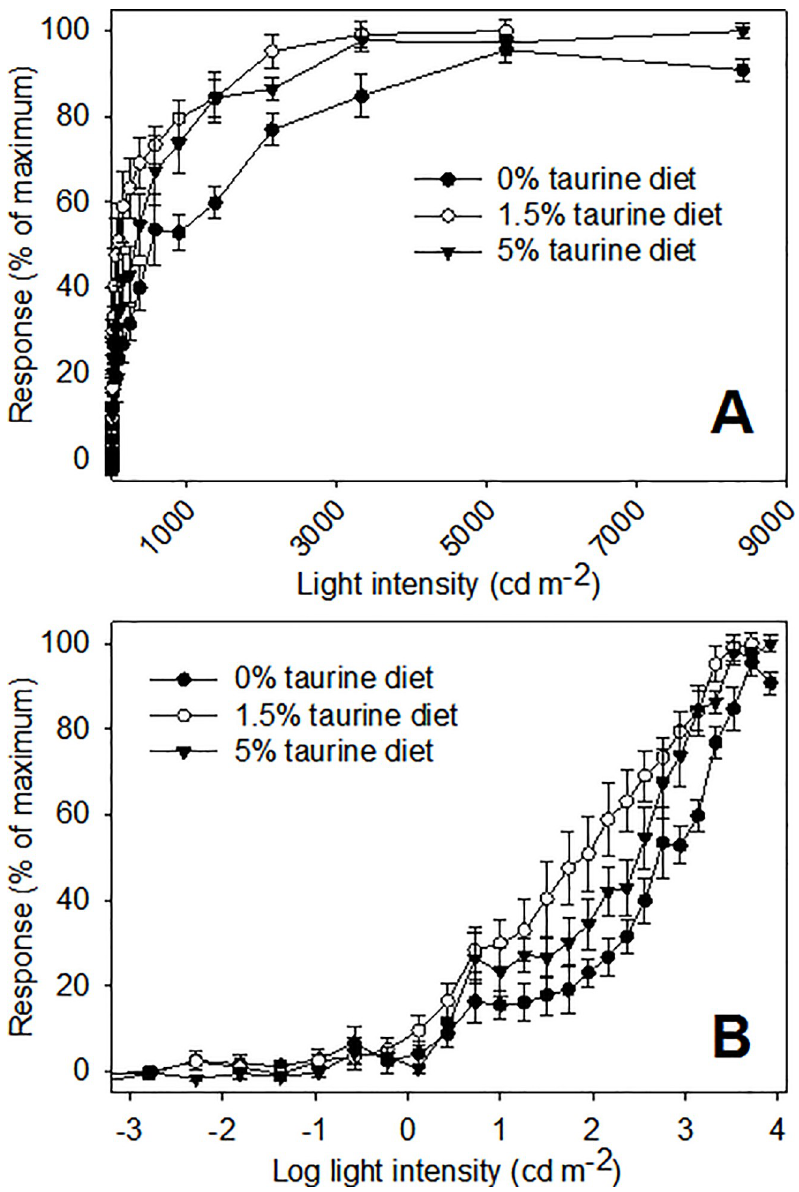
Fig 4. Luminous sensitivity (i.e., intensity–response curves) of European sea bass. Data are mean values ( ± SEM). Response values for individuals were normalized to 0–100%, the values averaged, and the mean values rescaled to 0–100%. Panel A shows luminous sensitivity with light intensities expressed in candela per square meter. Panel B shows the same data, but with light intensities expressed in log units. Increases in light intensity were in 0.2 log unit